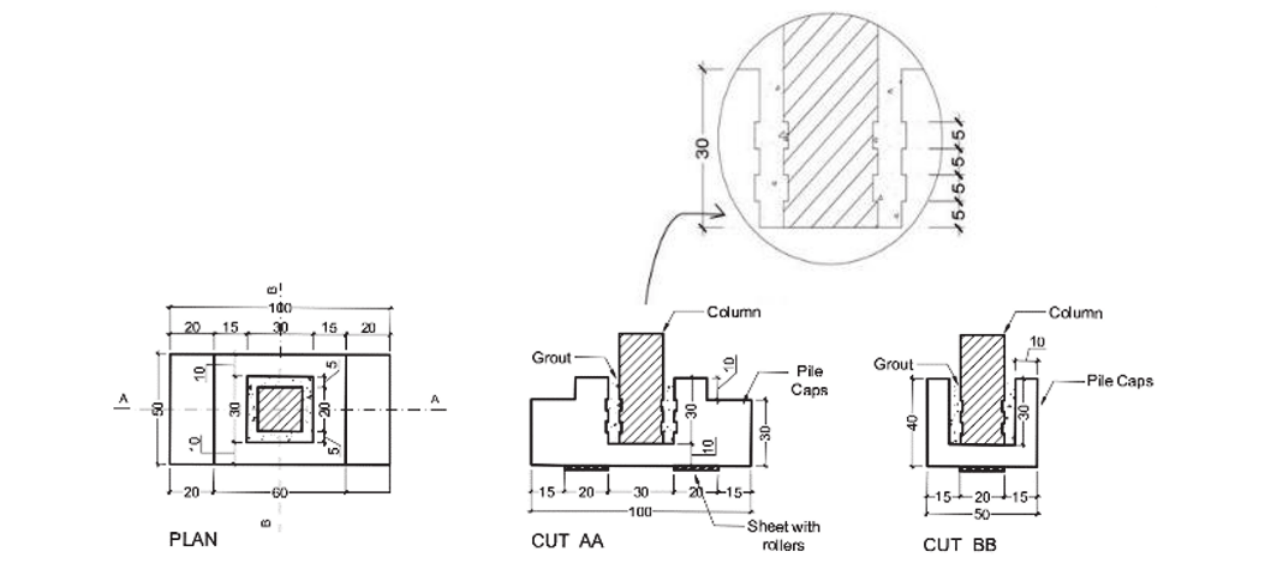
Figure 2 – Geometric properties of the rough connection pile caps of wall of the cup and the